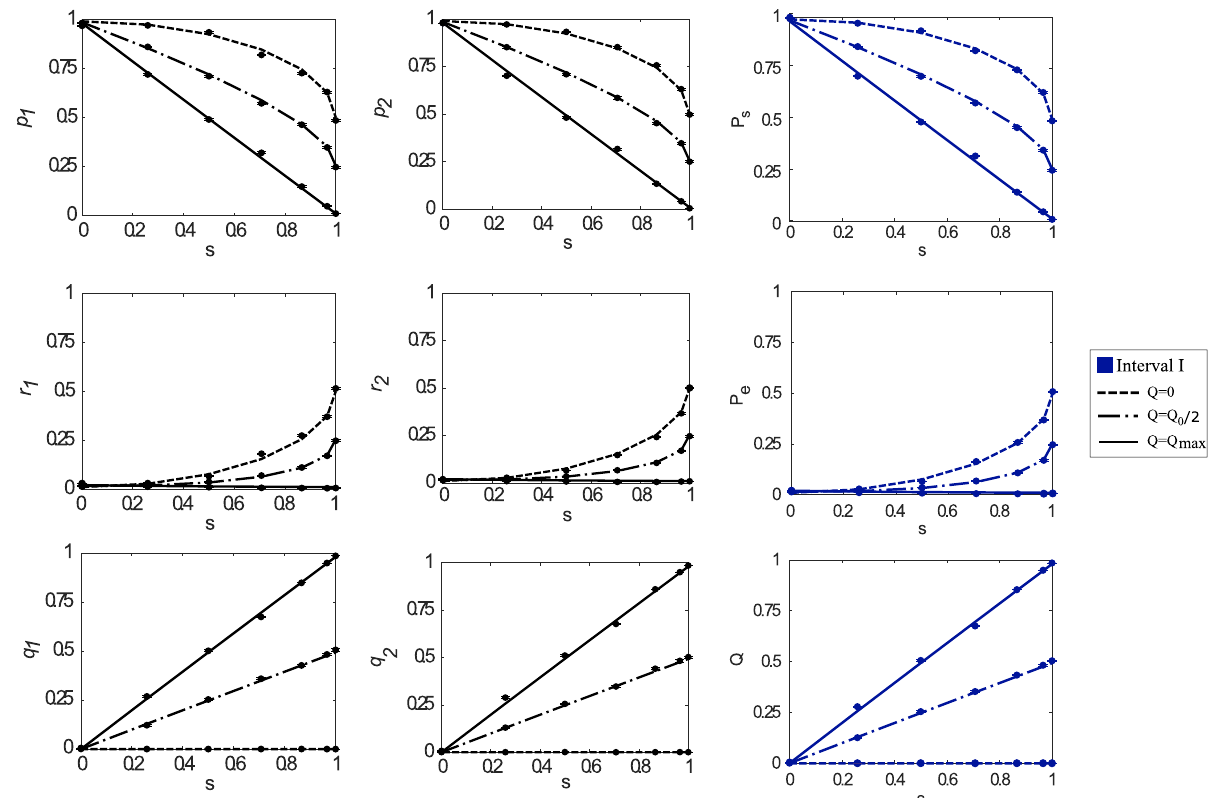
Figure 2. The success P s , error P e and inconclusive Q average probabilities as a function of the inner product 0.5 for both states φ i η 2 s , when η 1 are plotted in the third column. The first (second) column shows the � | = = success p 1 ( 2 ) , error r 1 ( 2 ) and inconclusive q 1 ( 2 ) rates when Alice prepares the state FRIO. The solid and dashed lines in each subplot represent the different values for the mentioned probabilities considering three different values for Q . They were computed using Eq. (8). As was aforementioned, for equally prepared states, we have only access to interval I, which is represented by the blue color in all subplots. Thus, η 2 , each state’s success, error, and inconclusive rates behavior is the same while the inner product s since η 1 =